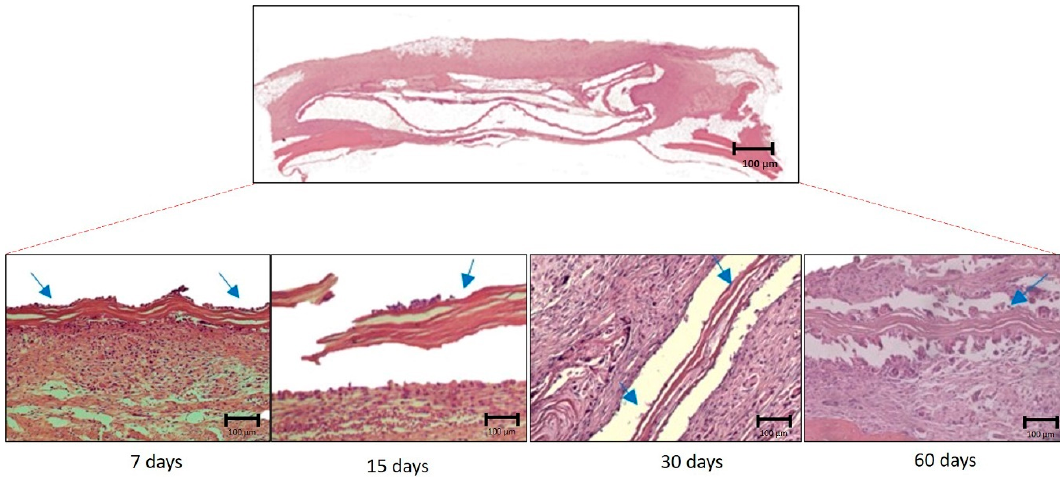
Figure 6. Photomicrographs of the smallest ( × 6.3) and largest ( × 12.5) histological sections for the BC experimental group in all postoperative periods (7, 15, 30, and 60 days), demonstrating the presence of the bacterial cellulose membrane (blue arrows).